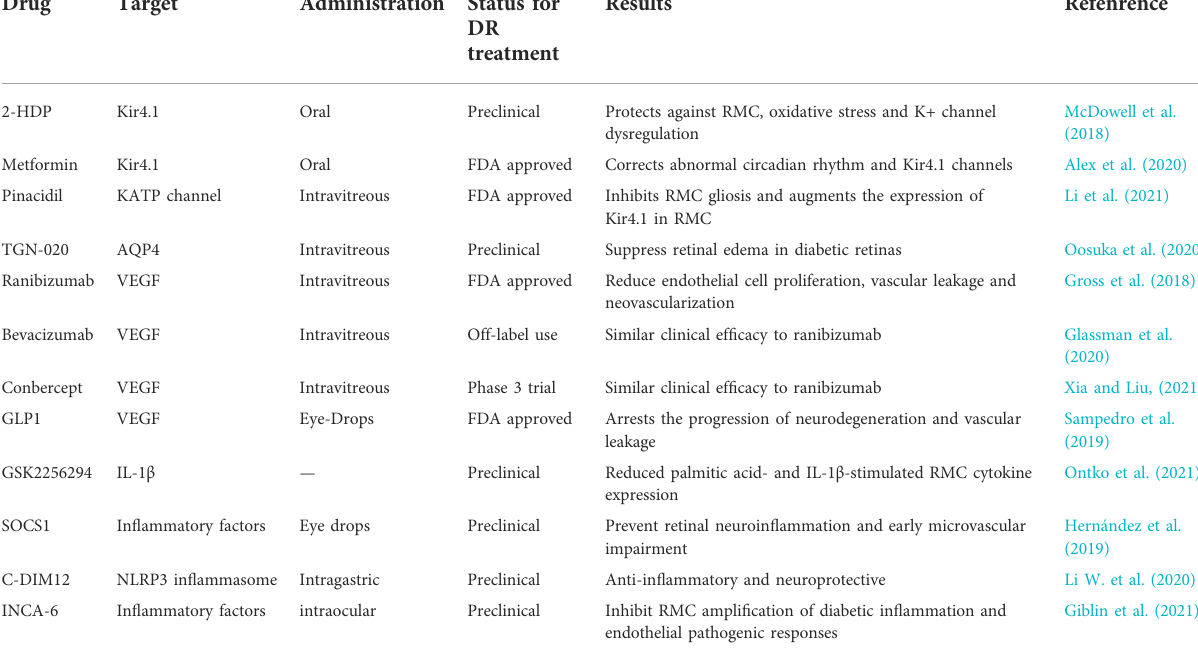
TABLE 1 Retinal Müller cells (RMCs) as a target for diabetic retinopathy (DR) treatment. The table shows current and novel treatment strategies in DR related to